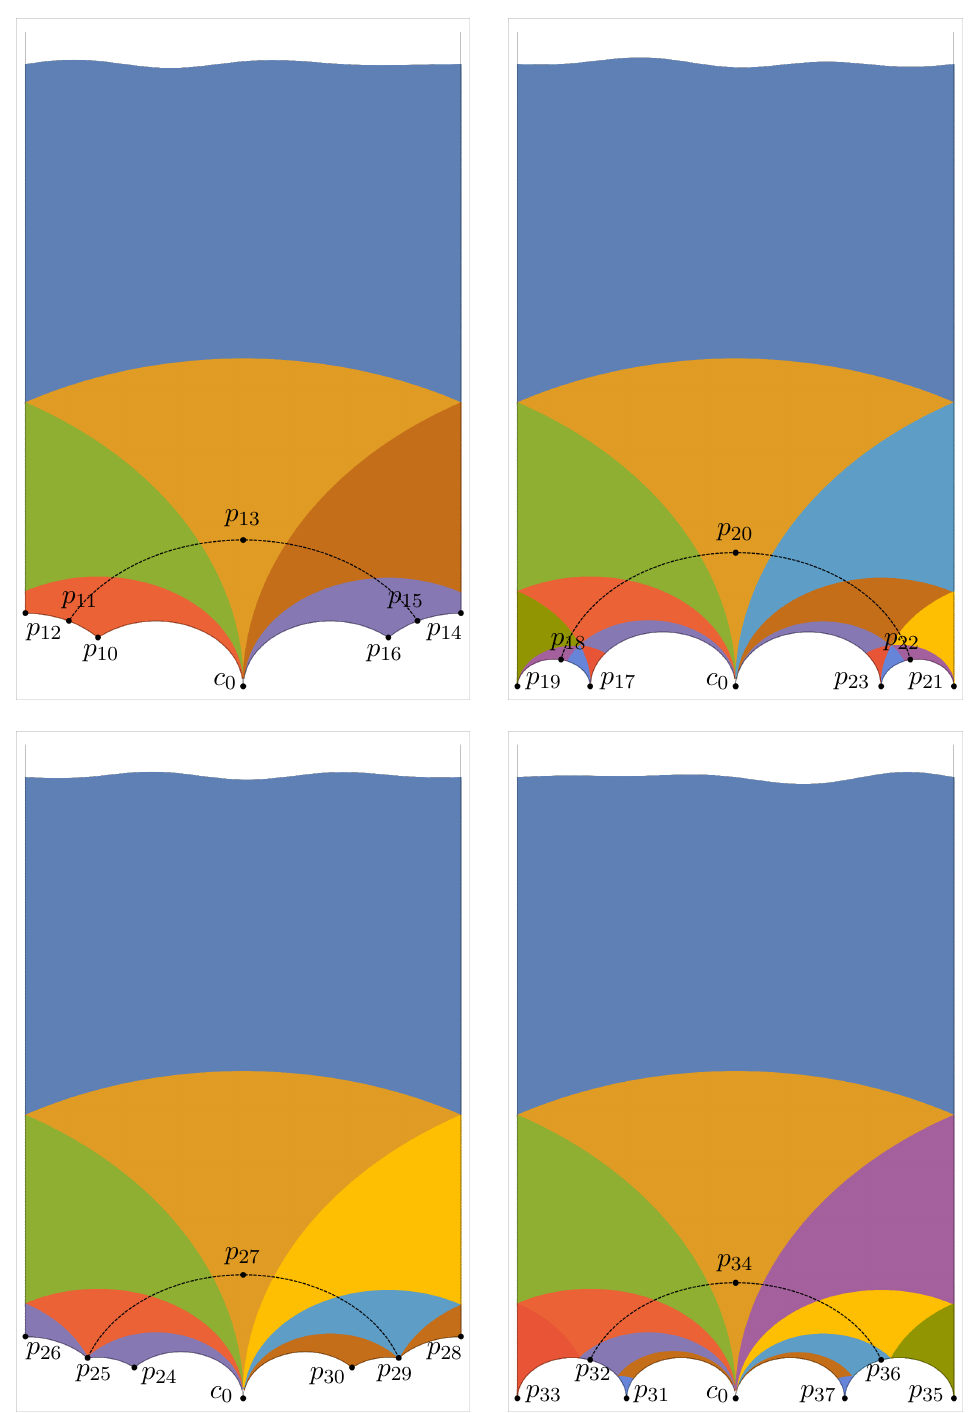
Figure 9 . Symmetric fundamental domains for Γ 0 ( N ) with N = 5 , 6 , 7 , 8 . In each case, a funda- mental domain for Γ ( N ) + is obtained by taking only the part above the dashed line, corresponding 0 to quotienting by F . The labelled points are listed in table N